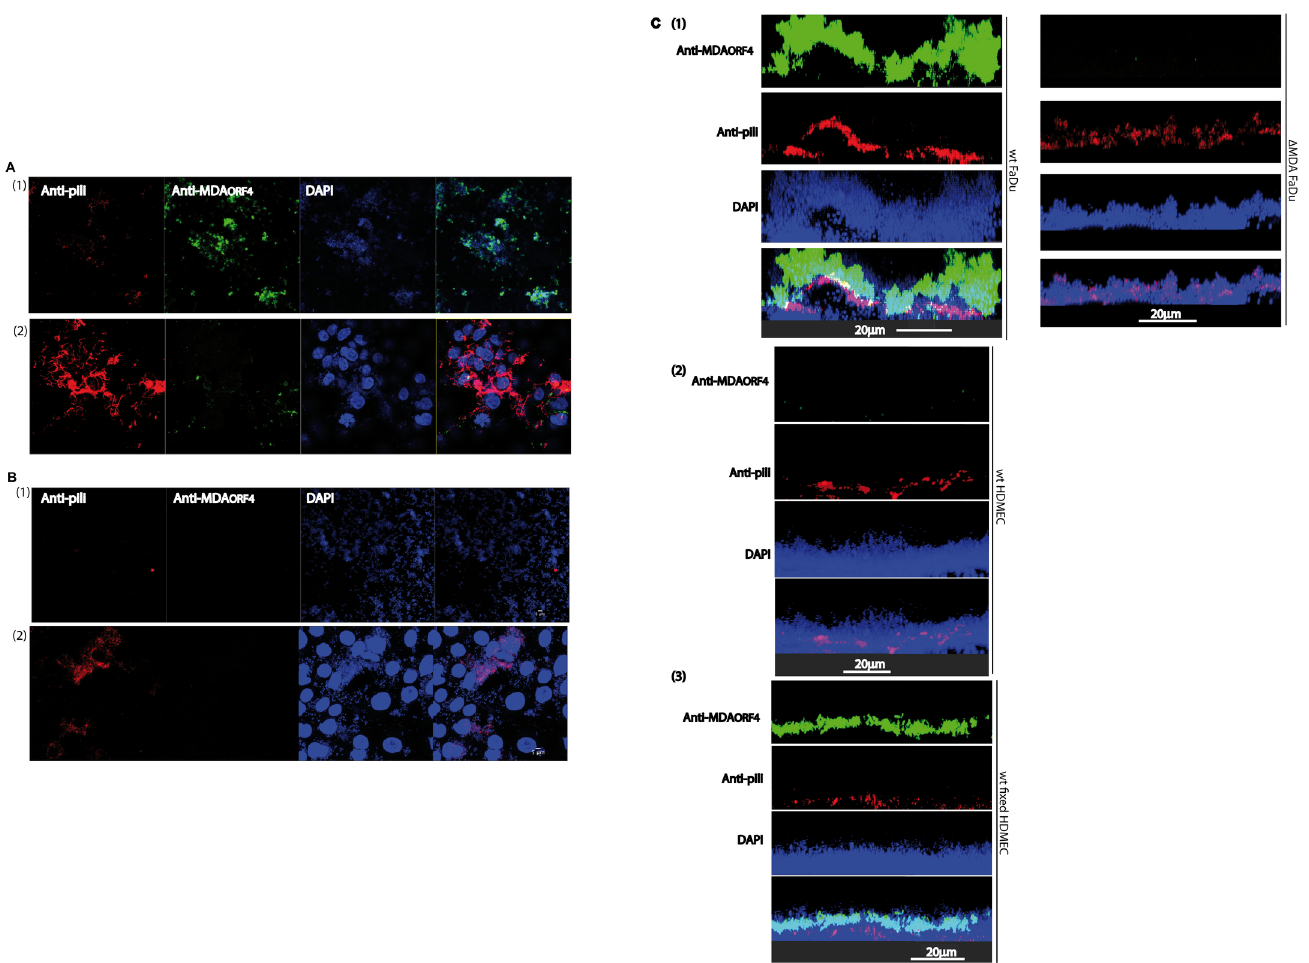
Fig 5. Detection of phage particles and type IV pili in bacteria colonizing the epithelial cell monolayer. Monolayers of FaDu cells in a flow chamberwere infected either with the wild-typestrain Z5463(SB- aph3’ )(A) or with the MDA Φ deletedstrain (Z5463(SB- aph3’ ) Δ MDA) (B) under constant flow for 18 hours. Bacteria were then aspirated from the flow chamberleavingbacteriaadheringonto the apical surface of the epithelial cells. The materialrecoveredby aspiration((1) top panel) and the remainingbacteria adheringonto the monolayers ((2) bottom panel)were stained by immunofluorescenceusing the anti MDAORF4 polyclonalantibody (in green) and the 20D9 monoclonal antibody (in red). With both strains, bacteriathat have not been harvestedare coveringthe host cells. These bacteriaare heavily piliated,and in the case of the WT strain very few phage particles were detected on this material, the green staining which corresponds to bacteriophages represents less 6% of the red surface which correspond to the pili staining.On the other hand, in the material harvestedby aspirationcorresponding to the upper layers of the biomass, bacteriaare surroundedby large quantity of bacteriophages (the red staining which corresponds to the pili represents 25% of the green surface which corresponds to the phage). (C) (1) Left pane, XZ section of a monolayerof FaDu cells in a flow chamberinfected with the wild-typestrain Z5463(SB- aph3’ )for 18 hours. Right panel XZ section of a monolayerof FaDu cells in a flow chamberinfected with the MDA Φ deletedstrain (Z5463(SB- aph3’ ) Δ MDA) for 18 hours. (2) XZ section of a monolayerof HDMEC cells in a flow chamberinfected with the wild-typestrain Z5463(SB- aph3’ )for 18 hours. (3) XZ section of a fixed monolayerof HDMEC cells in a flow chamberinfected with the wild-typestrain Z5463(SB- aph3’ )for 18 hours. The biomasswas stained by immunofluorescence using the anti-MDAORF4 polyclonal antibody (in green), the 20D9 monoclonal antibody(in red) and DAPI in blue.